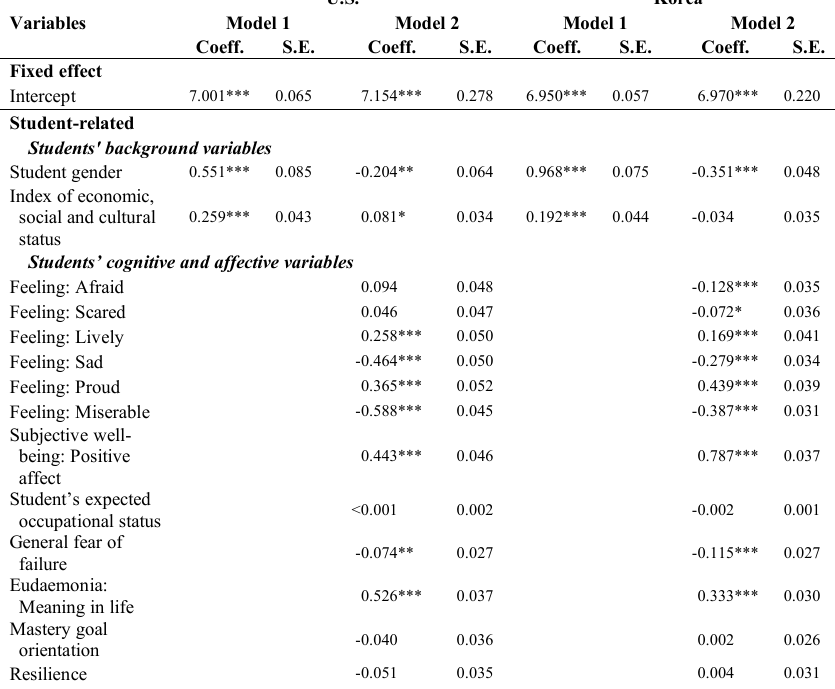
Effect of variables on students’ life satisfaction in U.S. and South Korea